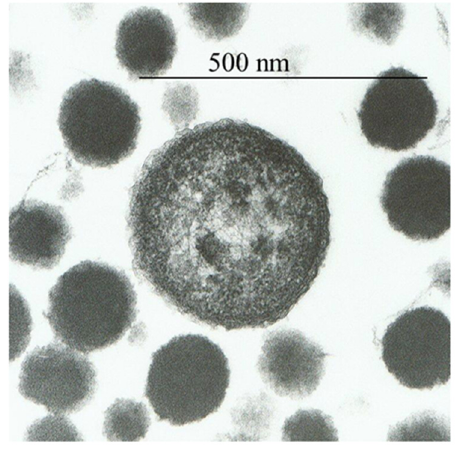
Figure 1. Electron micrographs of proteons from human blood. Proteons were incubated in culture medium proliferate, reaching saturation after 13 days [3]. The culture medium alone contained no proteons and served as a negative con- trol (Figure 2). The half-time of proliferation is eight days.